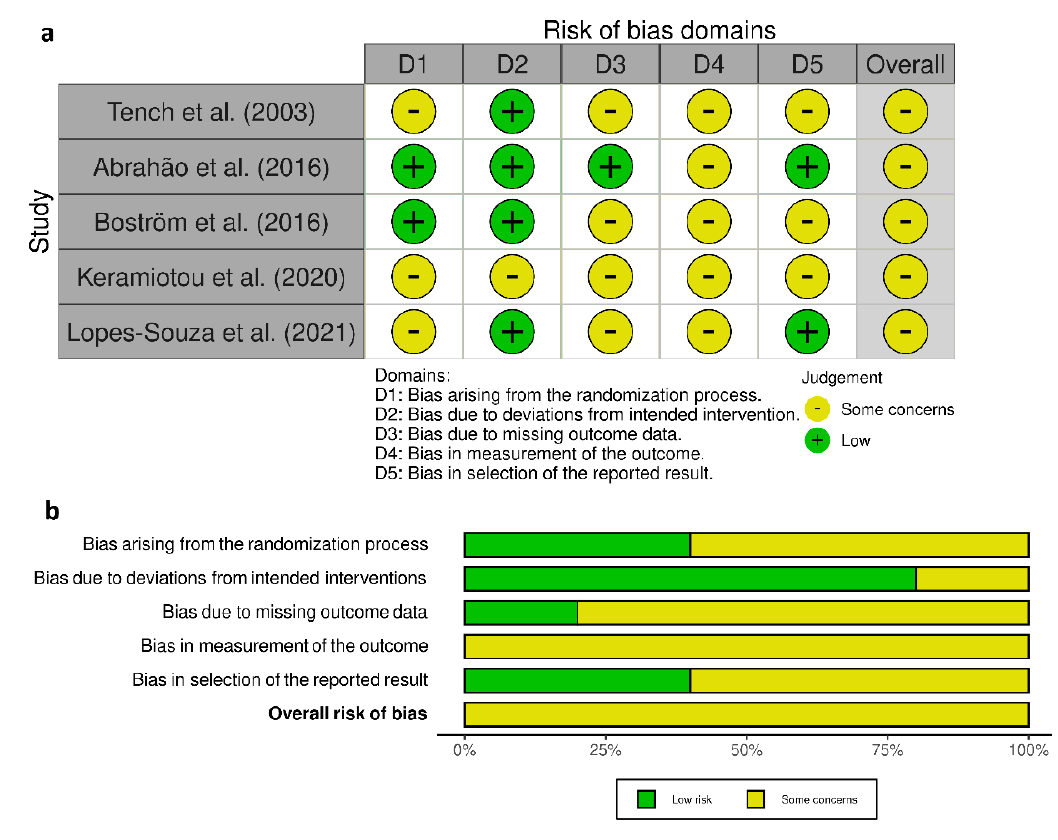
Figure 2. Risk of bias assessment: ( a ) Risk of bias summary. ( b ) Risk of bias graph.